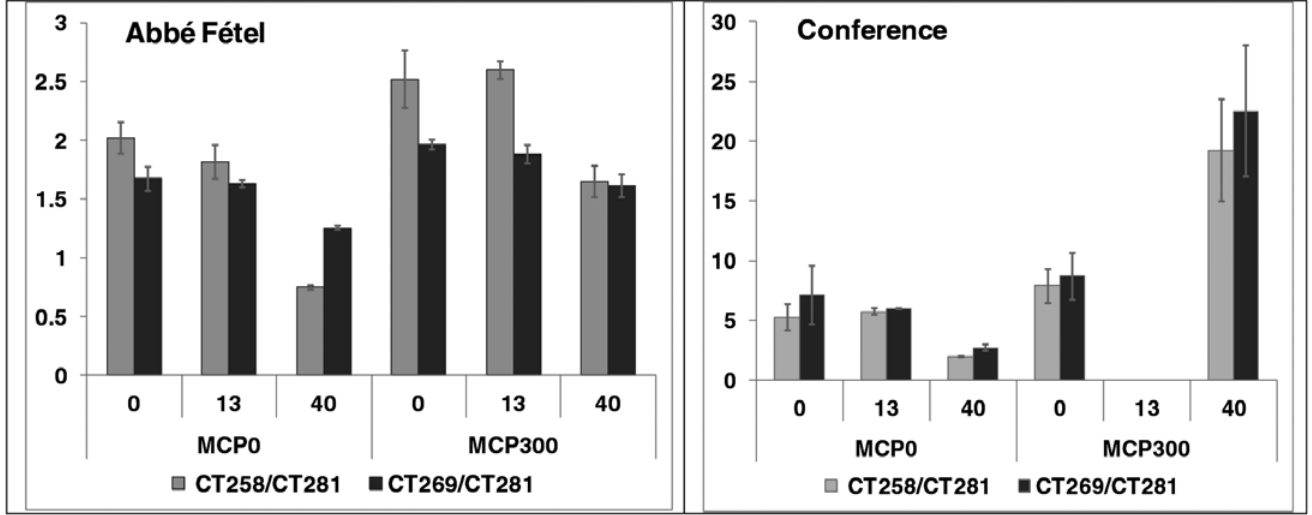
Fig. 2 - CTol /CTol and CTol /CTol ratios of control (MCP0) and 1–MCP treated (MCP300) ‘Abbé Fétel’ and ‘Conference’ pears at the 258 281 269 281 beginning (d0) and the end (d13) of the second ILOS period and in correspondence with the first storage time (d40). Bars refer to standard error of the